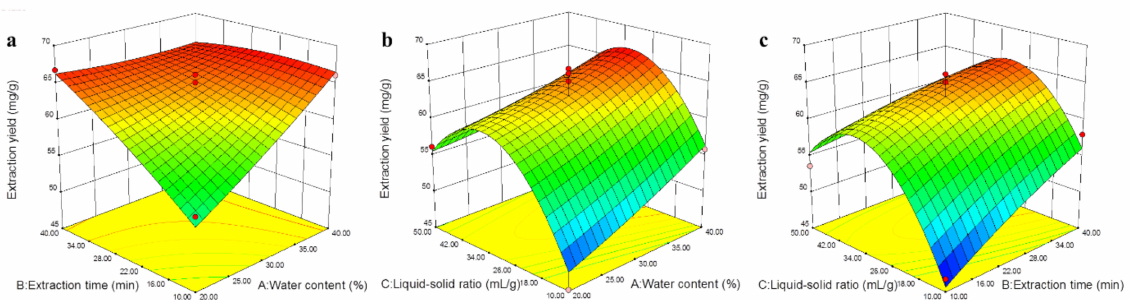
Figure 4. Response surface plots of the model for extraction of steroidal saponins from Dioscoreae Nipponicae Rhizoma (DNR). ( a ) water content (%) and extraction time (min); ( b ) water content (%) and liquid-solid ratio (mL/g); ( c ) liquid-solid ratio (mL/g) and extraction time